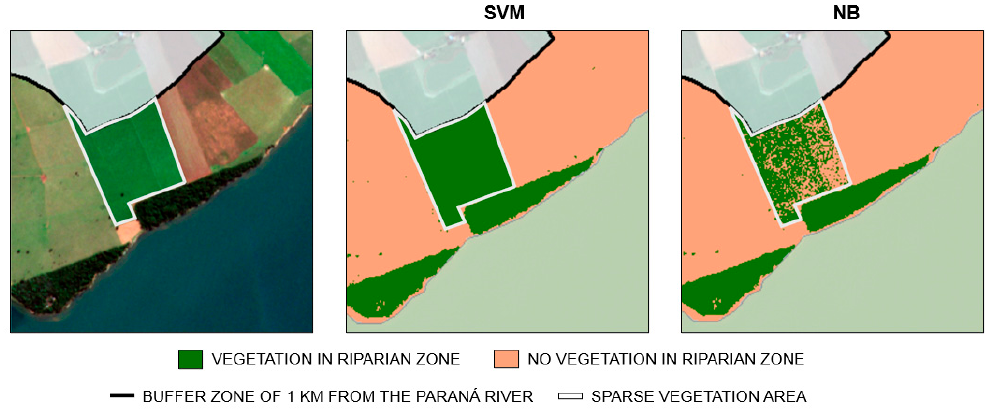
Figure 7. Examples of the classification of the SVM and NB algorithms in an area of sparse vegetation.